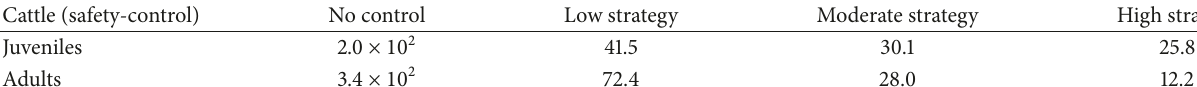
Table 5: Simulation results of the cumulative number of new cases at 𝑡 = 250 days for the juvenile and adult cattle using the safety-control strategy.